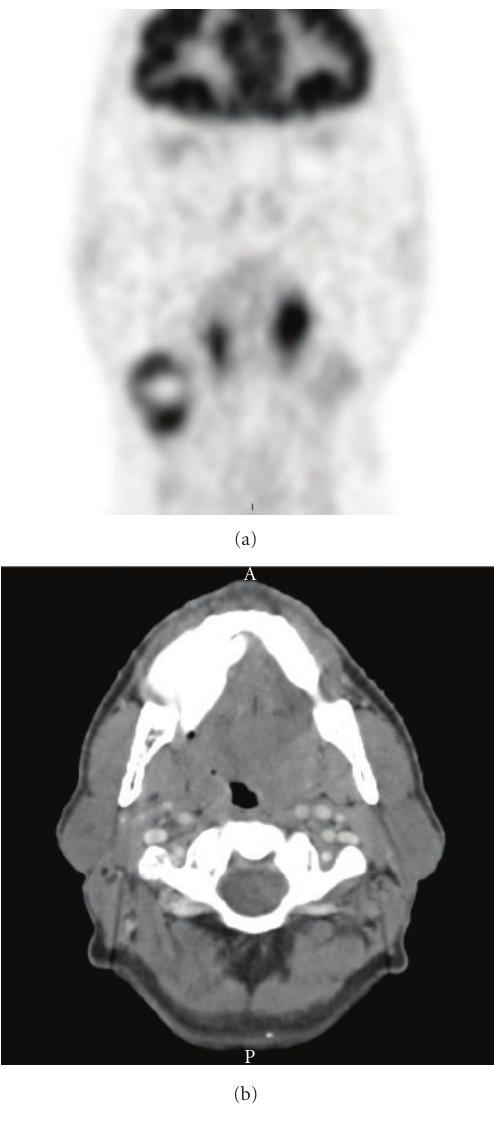
Figure 2: (a) Coronal FDG PET showing bilateral but asymmetric tonsillar FDG avidity. The patient had undergone diagnostic right tonsillectomy prior to this PET/CT study. However, peak SUV in the contralateral left palatine tonsil measured 8.7. (b) Axial CT showing pronounced left-sided tonsillar enlargement corresponding to the high FDG